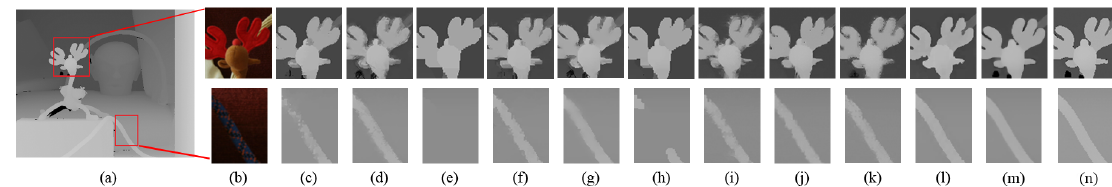
Figure 8. Example depth map SR results of Reindeer with two ROI. ( a ) Ground truth depth map, ( b ) color regions, and SR results of ( c ) Diebel et al. [22] (BP% = 3.95) , ( d ) JBU [11] (3.36) , ( e ) Lu et al. [23] (3.48) , ( f ) Kim et al. [24] (2.14) , ( g ) Jung [17] (2.91) , ( h ) Lo et al. [3] (1.97) , ( i ) Park et al. [26] (3.86) , ( j ) Ferstl et al. [27] (1.93) , ( k ) Choi et al. [18] (2.42) , ( l ) Lo et al. [21] (1.42) , ( m ) Our method (0.74) , and ( n ) the associated ground